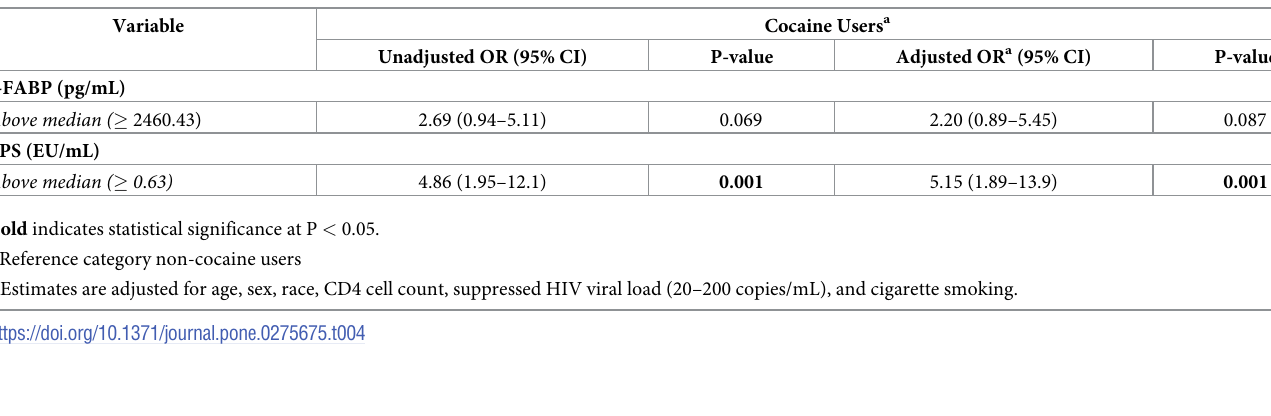
Table 4. Logistic regression analysis predicting the likelihood of high levels of gut integrity damage and microbial translocation in cocaine users living with HIV. Variable